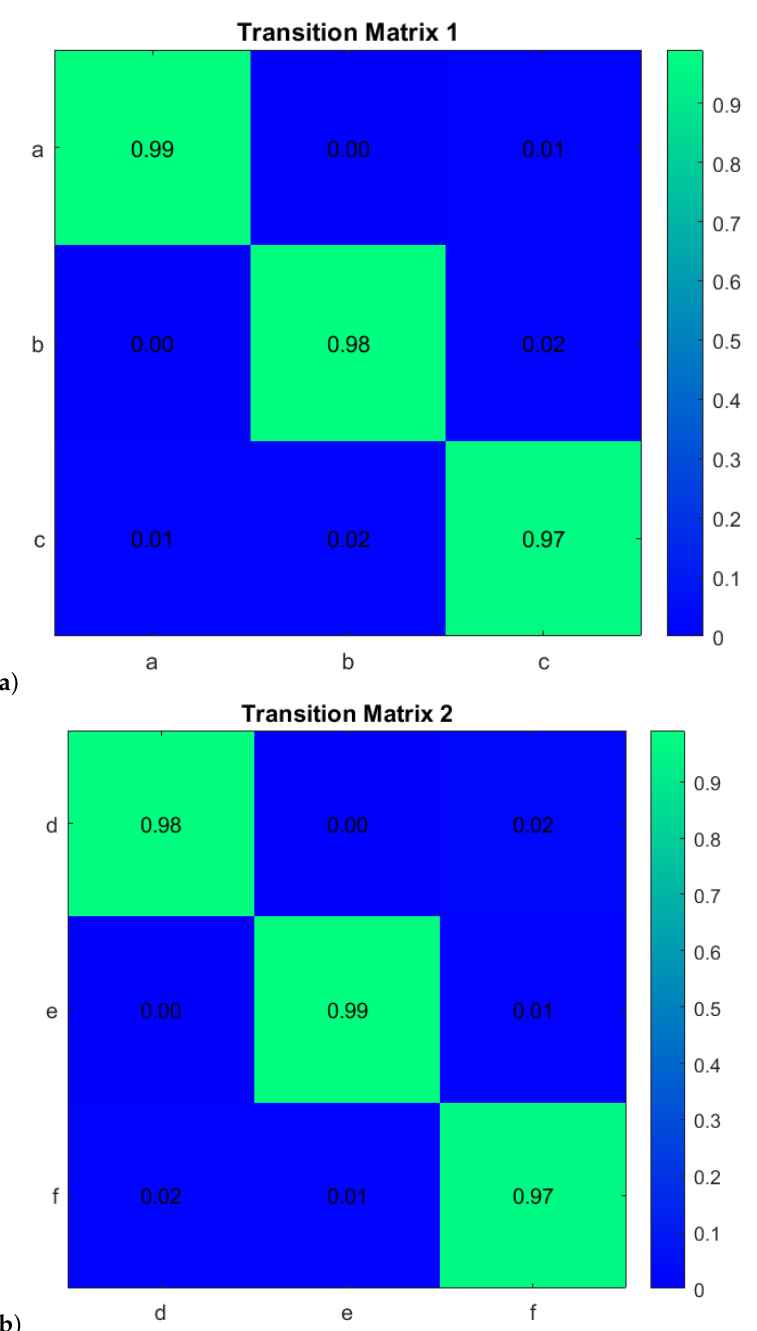
Figure 12. Transition probability matrices obtained from the initial model (training phase) for ( a ) agent 1 and ( b ) agent 2